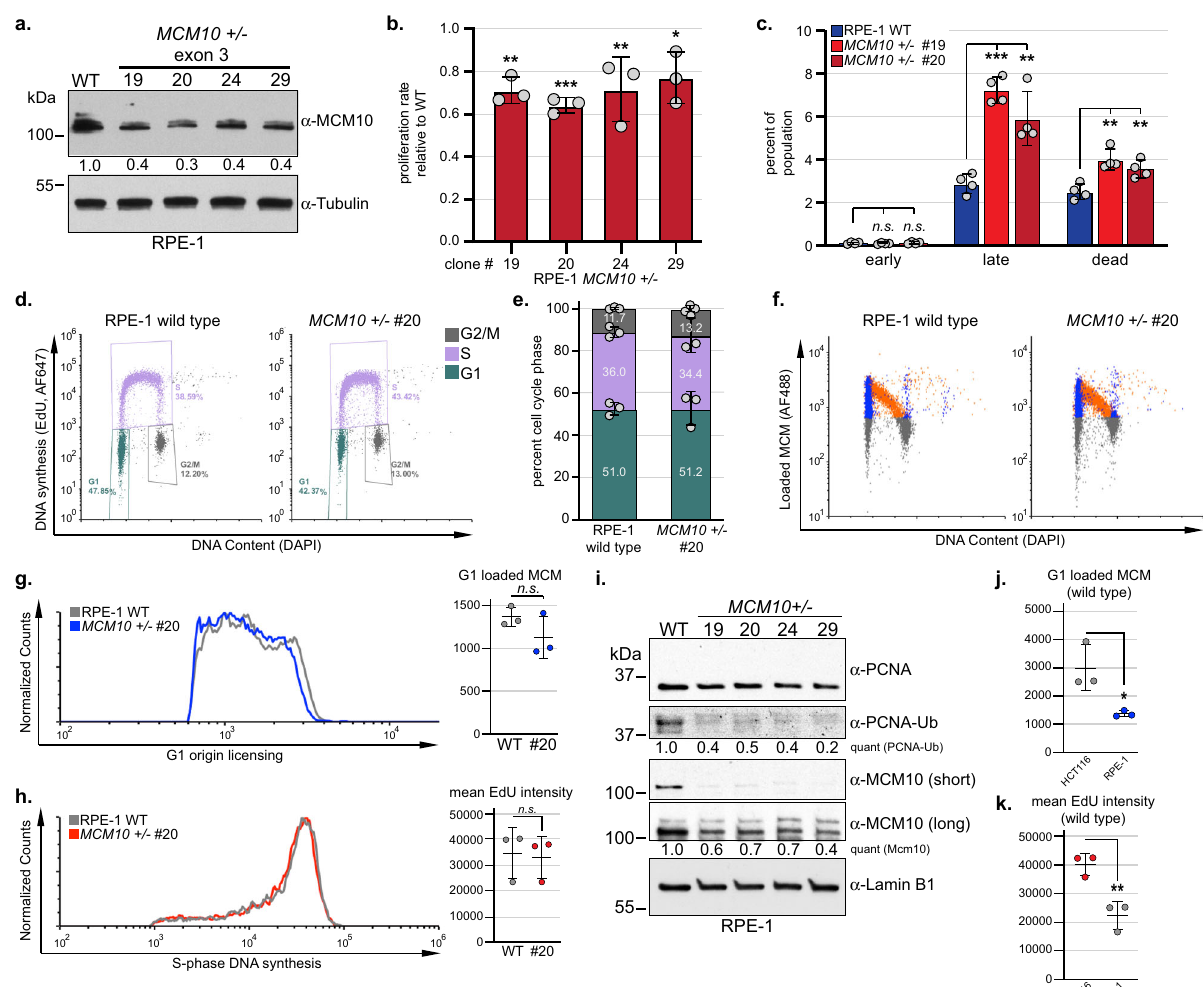
Fig. 4 MCM10 heterozygous RPE-1 cell lines have reduced MCM10 expression, impaired proliferation, and fewer active replication forks. a Western blot for MCM10 with quanti fi cation normalized to tubulin relative to wild type is indicated. b Average proliferation rate in MCM10 + /- cells normalized to wild type. For each cell line n = 6 replicates. Average values for biological replicates are indicated (gray circles). c Average percentage of early apoptotic, late apoptotic, or dead cells. Wild type (blue) and clonal MCM10 + /- cell lines (red) are shown. For each cell line n = 4. Individual data points are indicated (gray circles). d Cell cycle distribution of wild type and MCM10 + /- cells. Percentage of each population in G1- (green), S- (purple), and G2/M-phase (gray) is shown. e Average cell cycle distribution of wild type and MCM10 + /- cells from three biological replicates. Percentage of each population in G1- (green), S- (purple), and G2/M-phase (gray). Individual data points are indicated (gray circles). f Flow cytometry plots for wild type and MCM10 + /- cells. G1-phase/ MCM positive cells (blue), S-phase/MCM positive cells (orange) and G1- or G2/M-phase/MCM negative cells (gray) are indicated. g Comparison of origin licensing (left) and average G1 loaded MCM2 in biological replicates ( n = 3) of wild type (gray) and MCM10 + /- cells (blue). h Comparison of S-phase DNA synthesis (left) and average EdU intensity in biological replicates ( n = 3) of wild type (gray) and MCM10 + /- cell lines (red). i Chromatin-associated PCNA, PCNA-Ub MCM10, and Lamin B1. Quanti fi cation of PCNA-Ub or MCM10 levels normalized to Lamin B1, relative to the fi rst lane is indicated. j Average G1 loaded MCM2 in biological replicates ( n = 3) of wild type HCT116 (gray) and RPE-1 (blue) cells. k Average EdU intensity in biological replicates ( n = 3) of wild type HCT116 (red) and RPE-1 (gray) cells. Error bars in b , c , e , g , h , and j , k indicate SD and signi fi cance was calculated using an unpaired, two-tailed student ’ s t-test with *<0.05; **<0.01, ***<0.001. Source data for panels a , b , c , e , g , h , i , j , and k , including relevant exact p-values, are provided in the Source Data fi le.